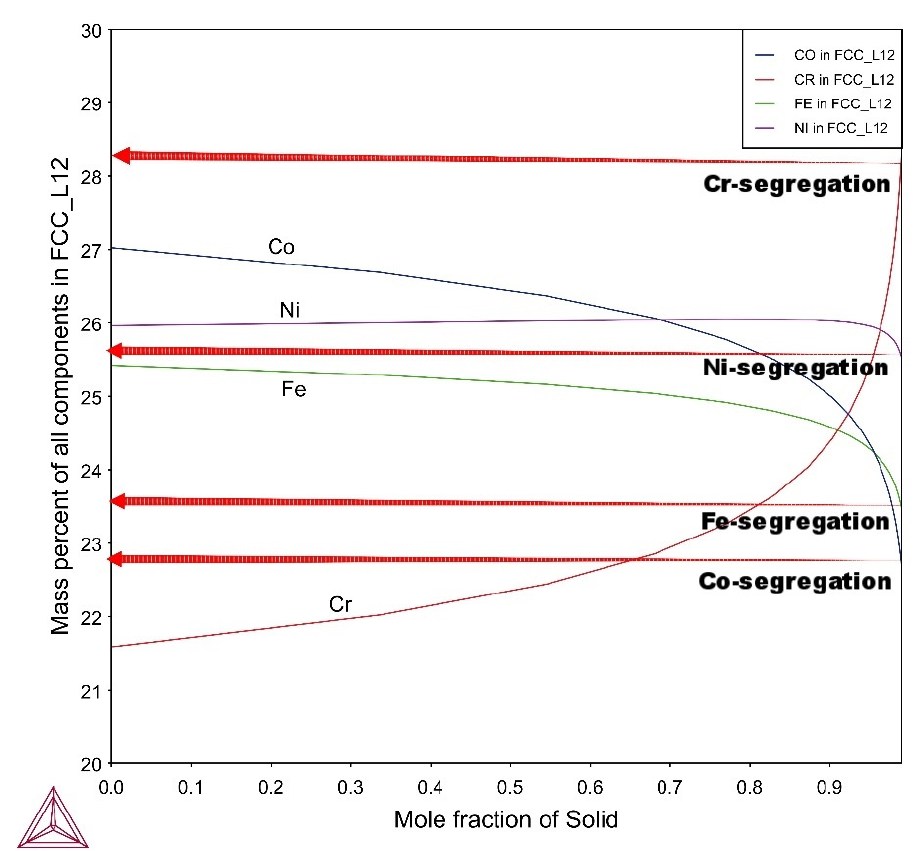
Figure 10. Calculated element segregation of as-printed samples under the solidification rate of 10 5 °C/s via the Scheil model.